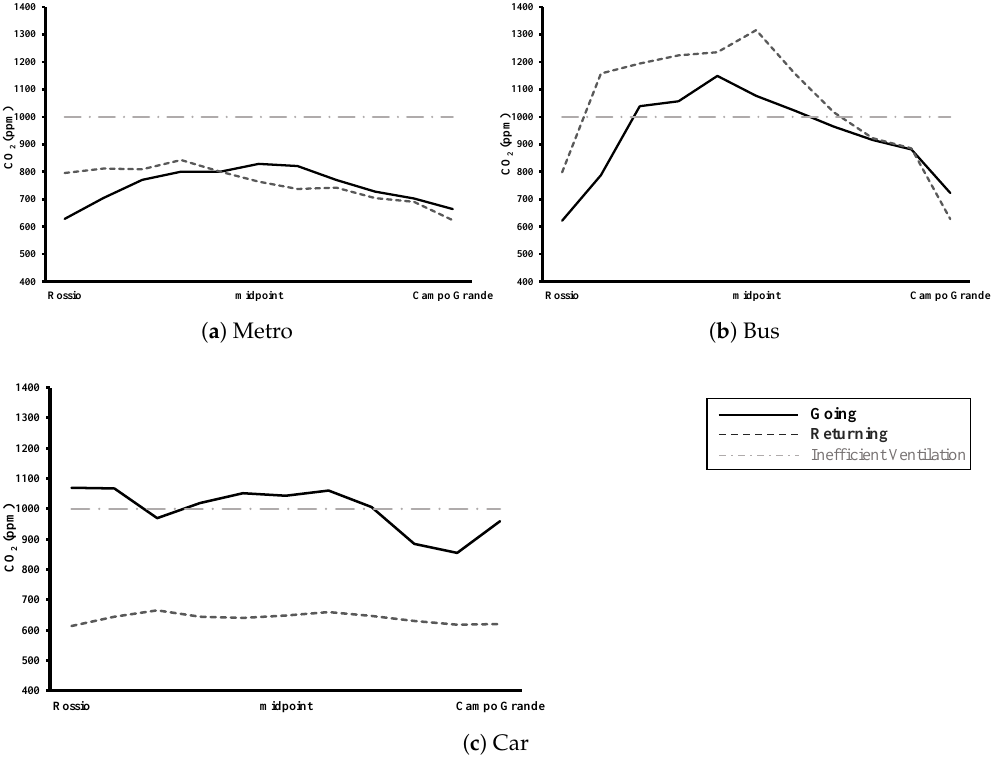
Figure 5. Temporal analysis of CO 2 . The dashed line is read from right to left. The dash-dotted line represents the threshold for efficient ventilation of 1000 ppm